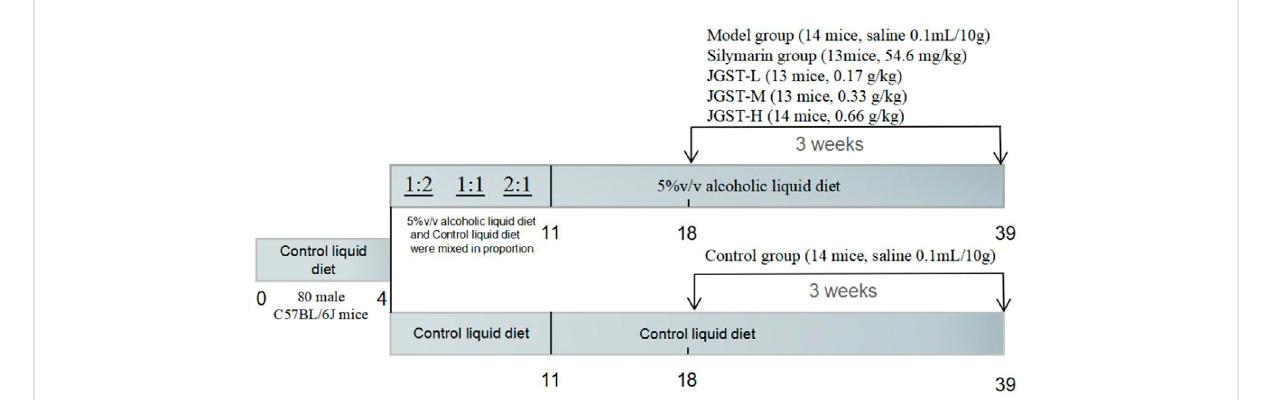
FIGURE 1 Overview of the alcohol induced liver injury mouse model